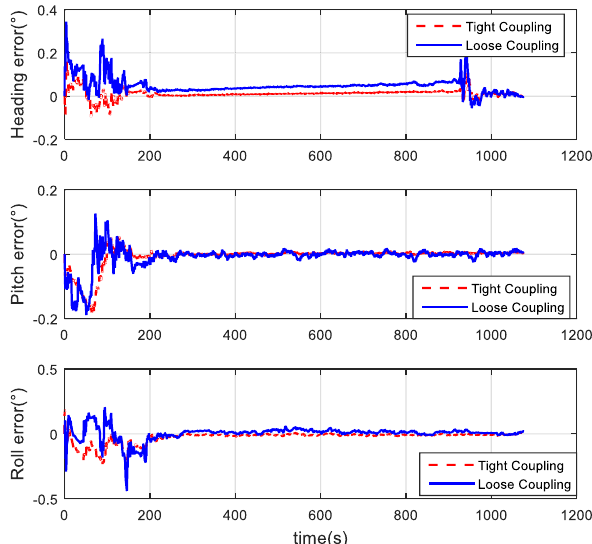
Figure 15. Attitude error comparison of loose and tight coupling.